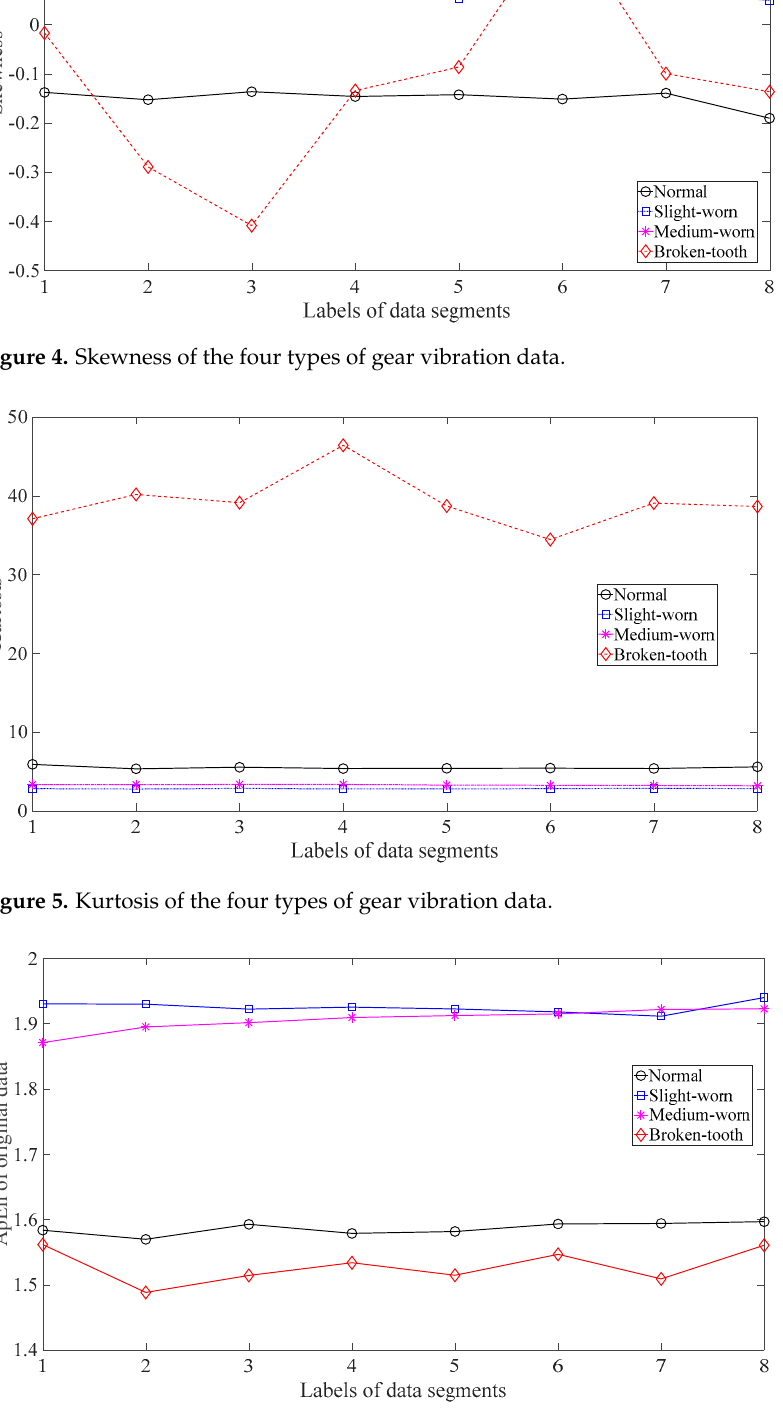
Figure 6. ApEn of the original versions of the four types of gear vibration data.